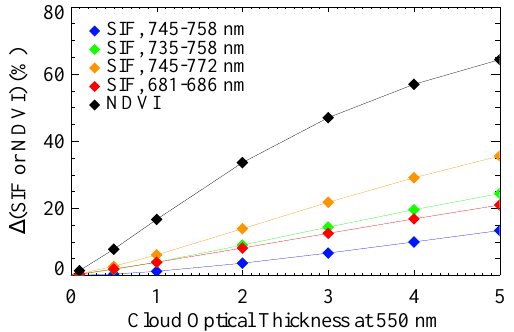
Figure 9. Simulated effect of cloud contamination (represented by cloud optical thickness at 550nm) on retrieved SIF and NDVI. Dif- Fig. 9: Simulated effect of cloud contamination (represented ferent retrieval fitting windows are tested in the case of SIF. The (cid:49) by cloud optical thickness at 550 nm) on retrieved SIF and symbol refers to the underestimation of SIF and NDVI under cloudy NDVI. Different retrieval fitting windows are tested in the conditions with respect to the clear-sky case of SIF. The ∆ symbol refers to the underestimation of SIF and NDVI under cloudy conditions with respect to the clear-sky case.